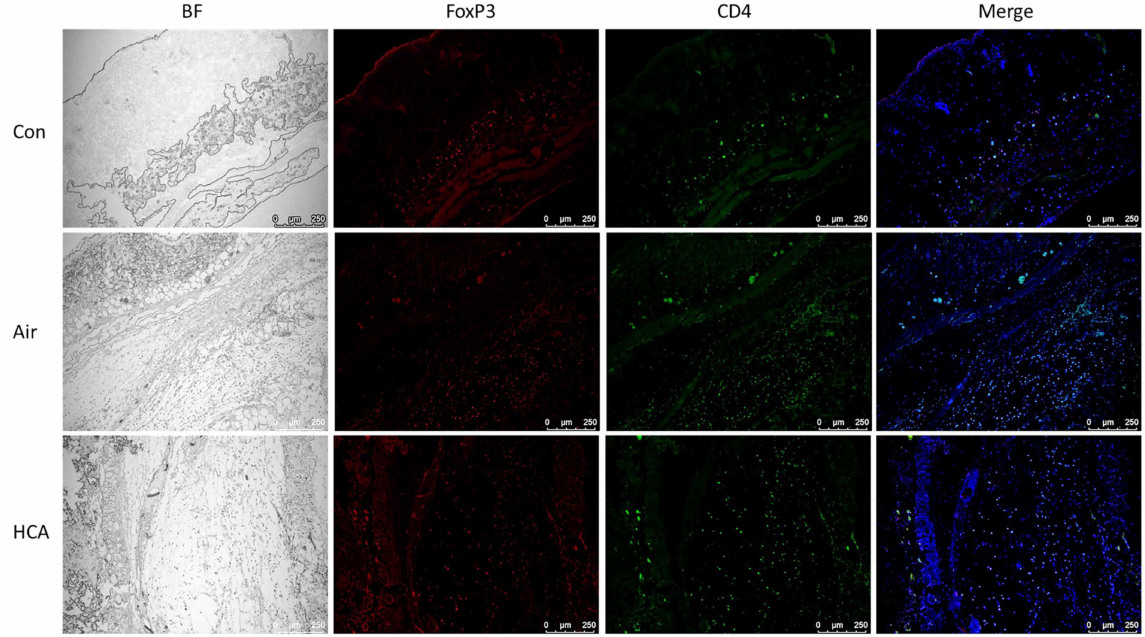
Figure 7. Immunofluorescence staining of FoxP3 and CD4 in skin grafts. The skin grafts from each group were performed with bright field (BF) or staining with anti-FoxP3 antibody (red), anti-CD4 antibody (green), and DAPI (blue) on day 3 after transplantation. A representative micrograph and merge image were shown (100 ×